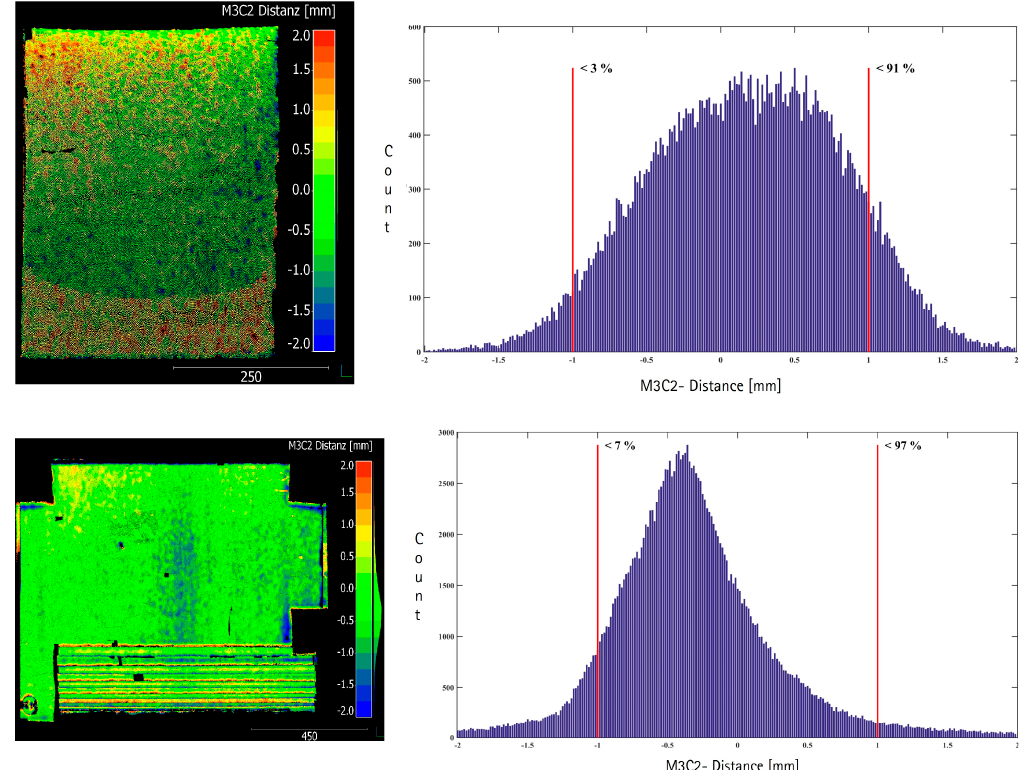
Figure 19. M3C2-distance [mm] calculated with Cloud Compare T-Scan 5 compared to ( top ) k-TLS for curved surface and ( bottom ) cuboids, Modified from [5].